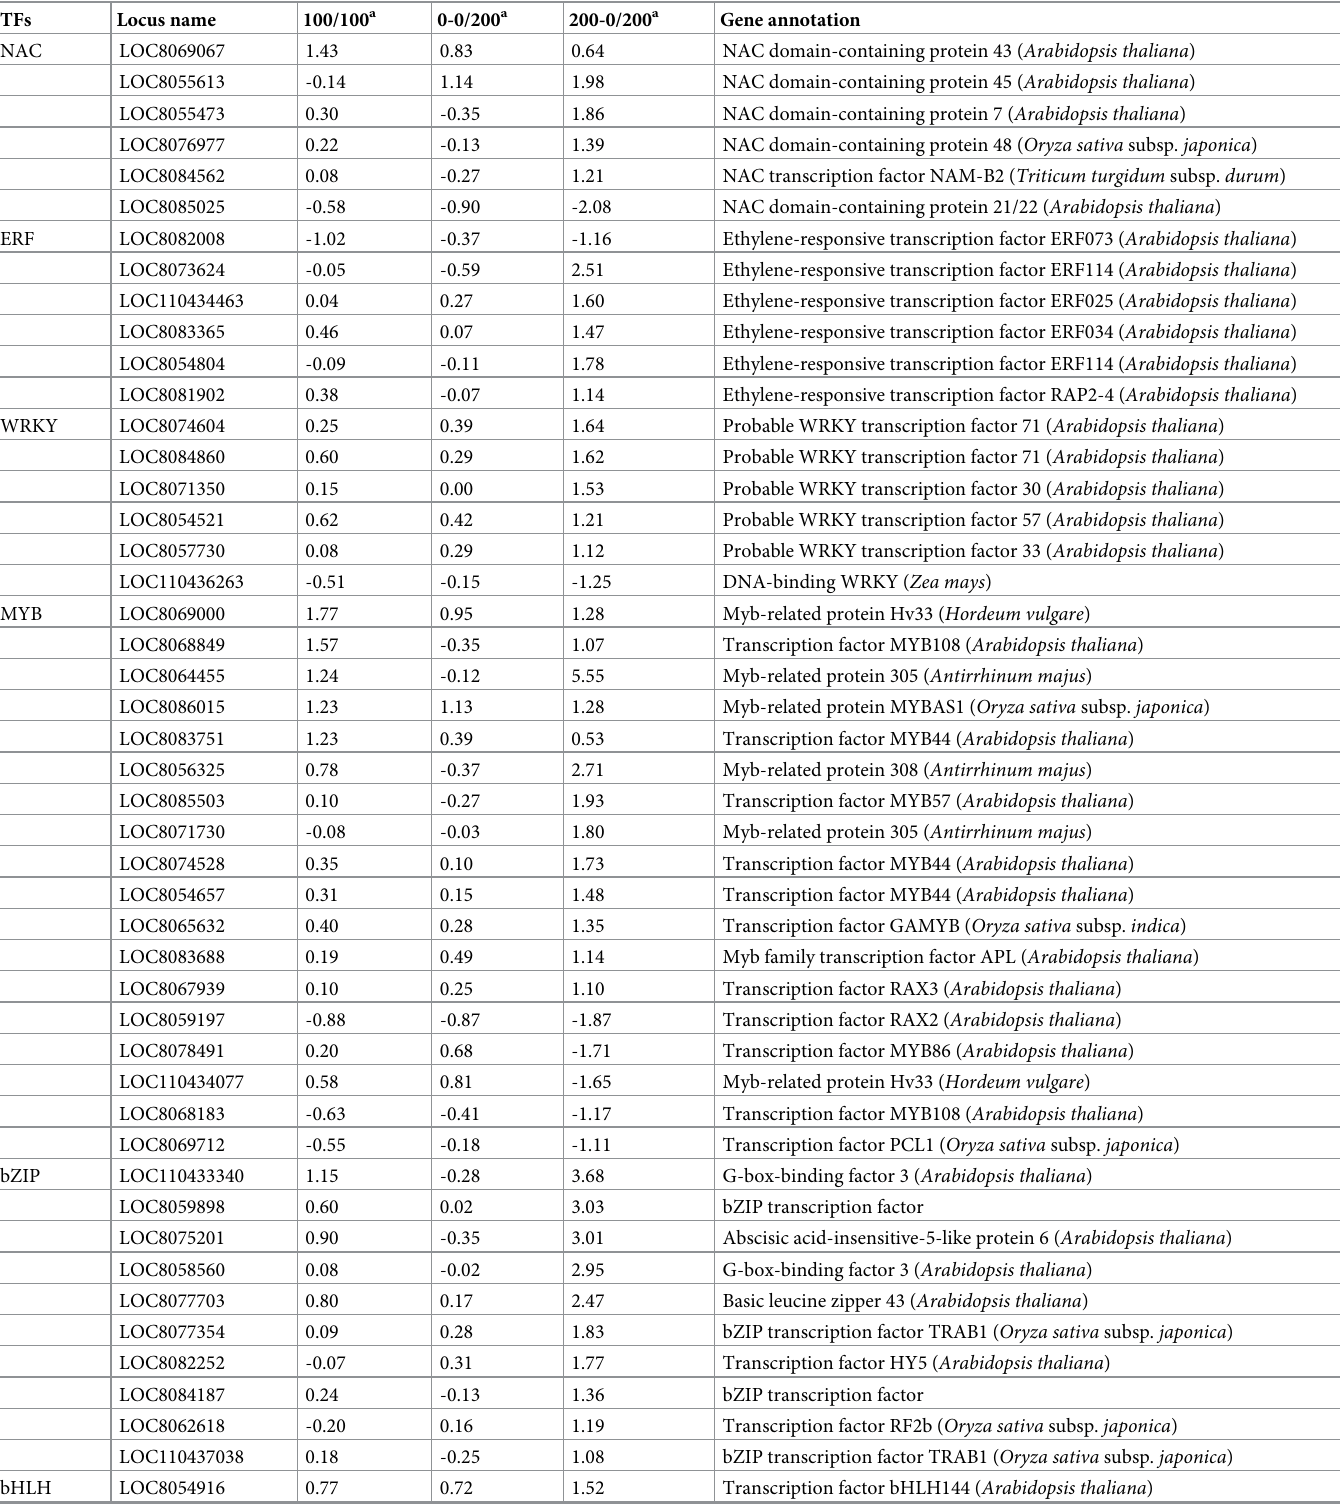
Table 5. Summary of differentially expressed transcriptional factors in roots under uniform and non-uniform salinity treatments.